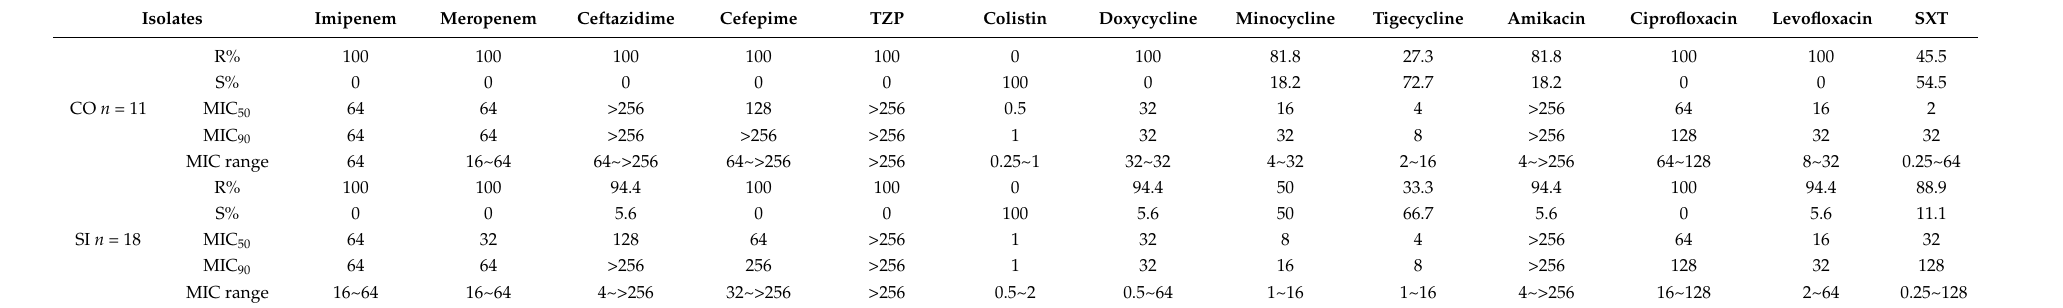
Table 2. The MIC 50 , MIC 90 , and MIC range ( µ g/mL) of CO and SI